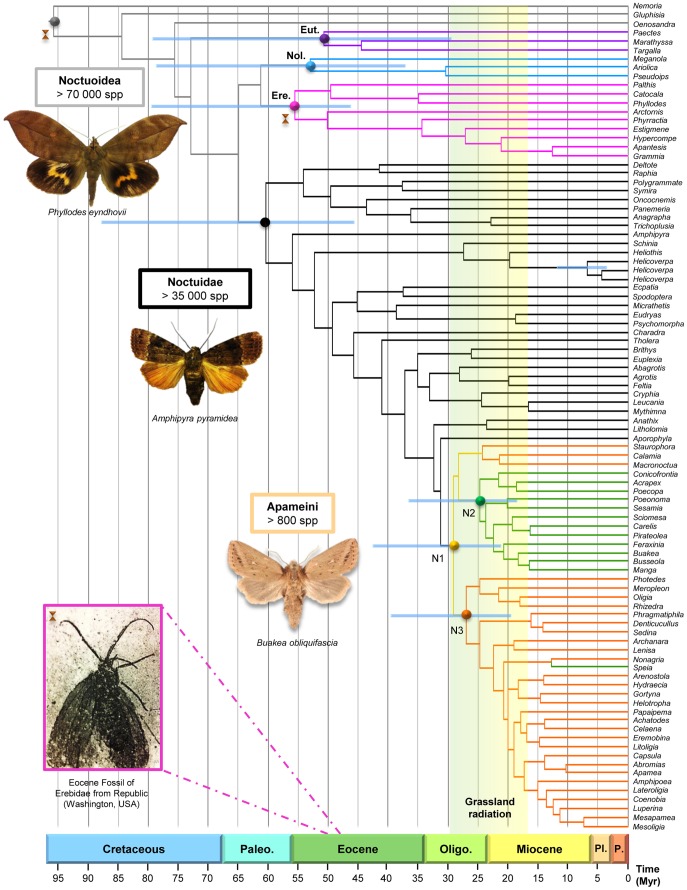
Maximum credibility tree with median ages (Myr) from the Bayesian uncorrelated uniform analysis under BEAST for the superfamily Noctuoidea.A 5 Myr-timescale is placed at the bottom of the chronogram and spans the Cretaceous to the Holocene. Brown hourglasses at the corresponding nodes indicate the calibration points used to ultrametrize the topology. For the fossil calibration, a picture of the moth in question retrieved from Douglas SD & Stockey RA (1996) is presented in the bottom left-corner. Horizontal blue bands represent the 95% HPD heights (in Myr) for the major nodes of the chronogram. Vertical bands and pastilles at the nodes of different colours referring to the colour of the clades highlight groups of interest. For the groups of major interest, the name is given in a box of the clade colour. Abbreviations for the clade names are: Ere.  =  Erebidae, Eut.  =  Euteliidae, Hel.  =  Helicoverpa, and Nol.  =  Nolidae. Genera of the Sesamiina and Apameina subtribes show respectively green and orange branches. Names of the species for which a habitus is displayed are specified under the picture (Pictures: EFA Toussaint & BP Le Ru).